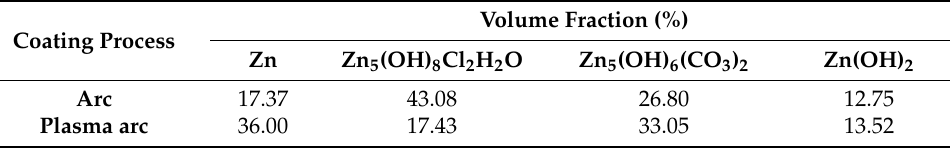
Figure 14. XRD of corrosion products formed on the Zn coatings after 23 d of exposure to artificial seawater. Table 7. Volume fraction of each phase found in corrosion Table 7. Volume fraction of each phase found in corrosion products.